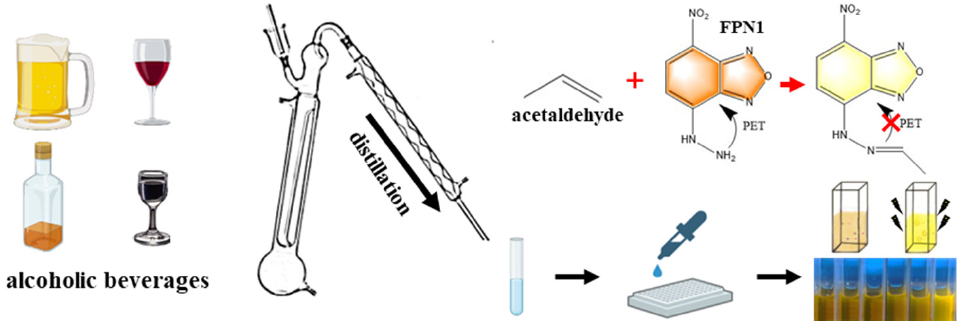
Figure 2. The schematic diagram of the fluorescence sensing method based on FPN1 with BRM.